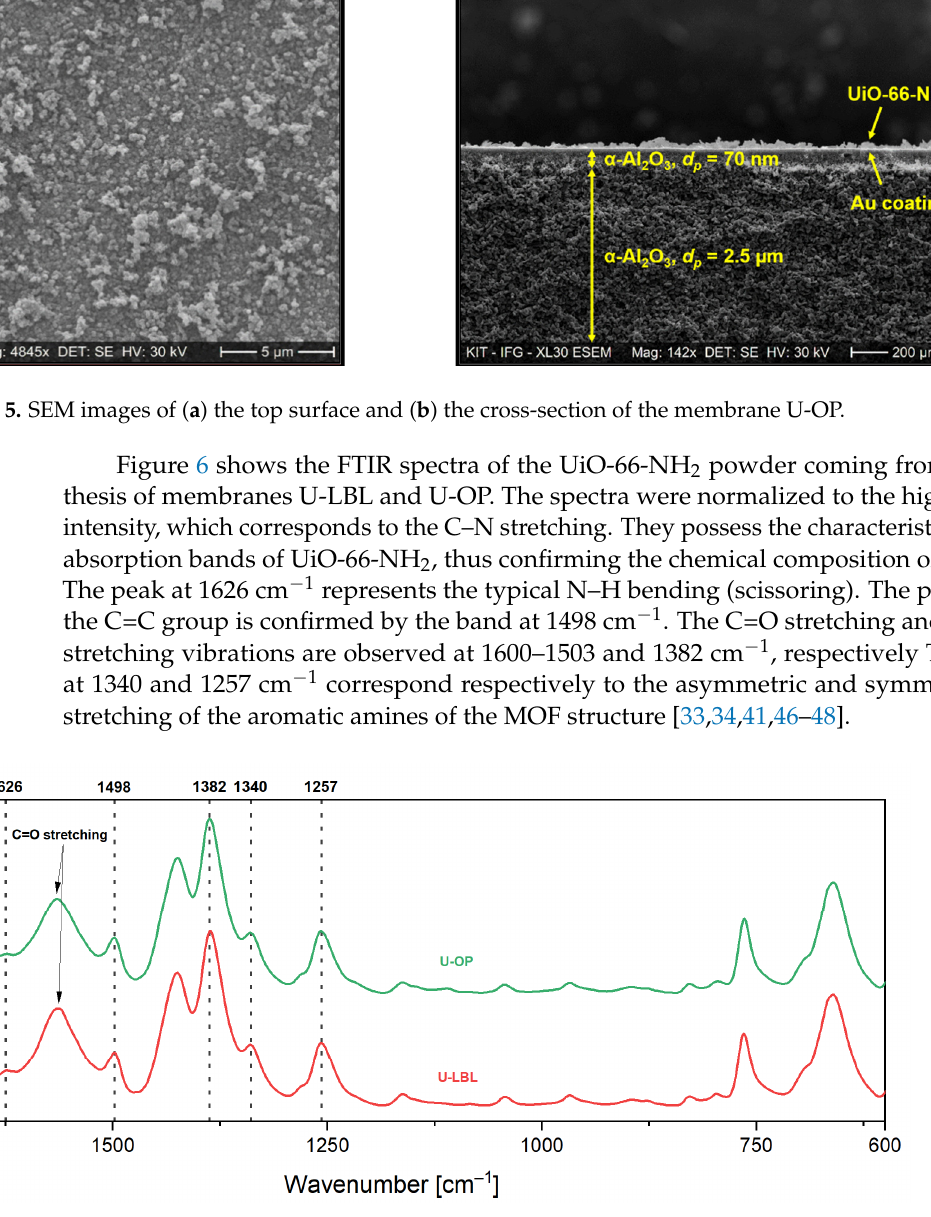
Figure 6. Normalized FTIR spectra of the UiO-66-NH 2 powder of samples U-LBL and U-OP.